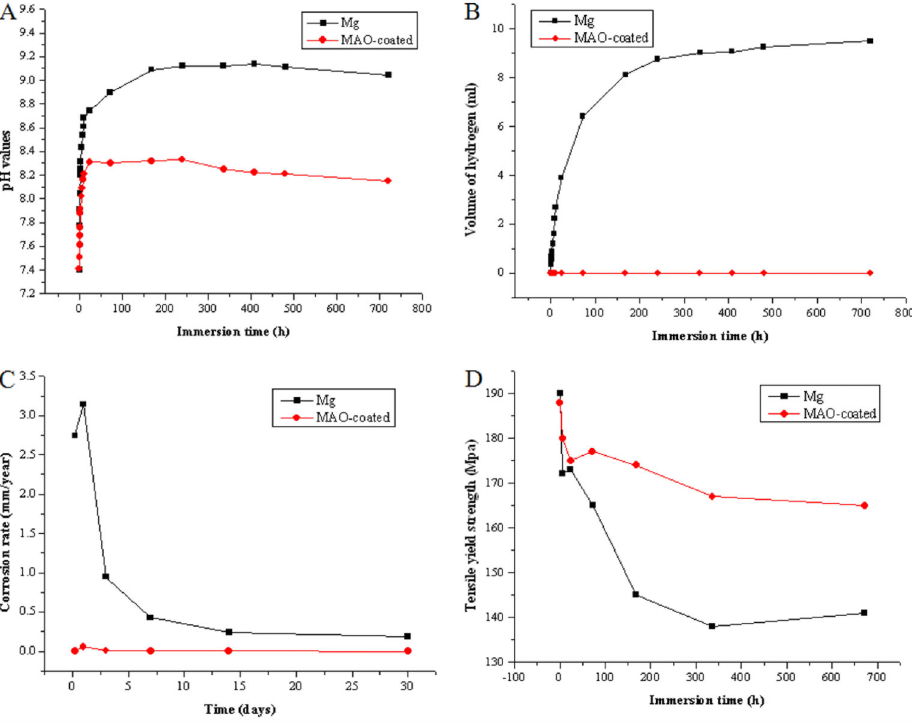
Figure 5. A , pH of simulated body fluid during 30 days of immersion for Mg and MAO-coated Mg. B , Hydrogen evolution volumes of the two implant materials over time. C , Corrosion rate of the two implant materials over time. D , Tensile strength of the two implant materials over time. MAO: micro-arc oxidation.